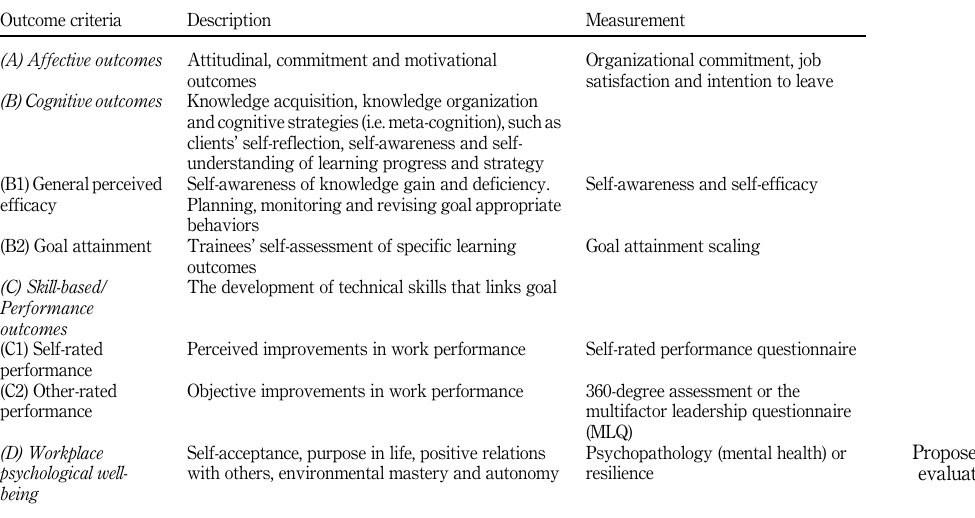
Table 2. Proposed